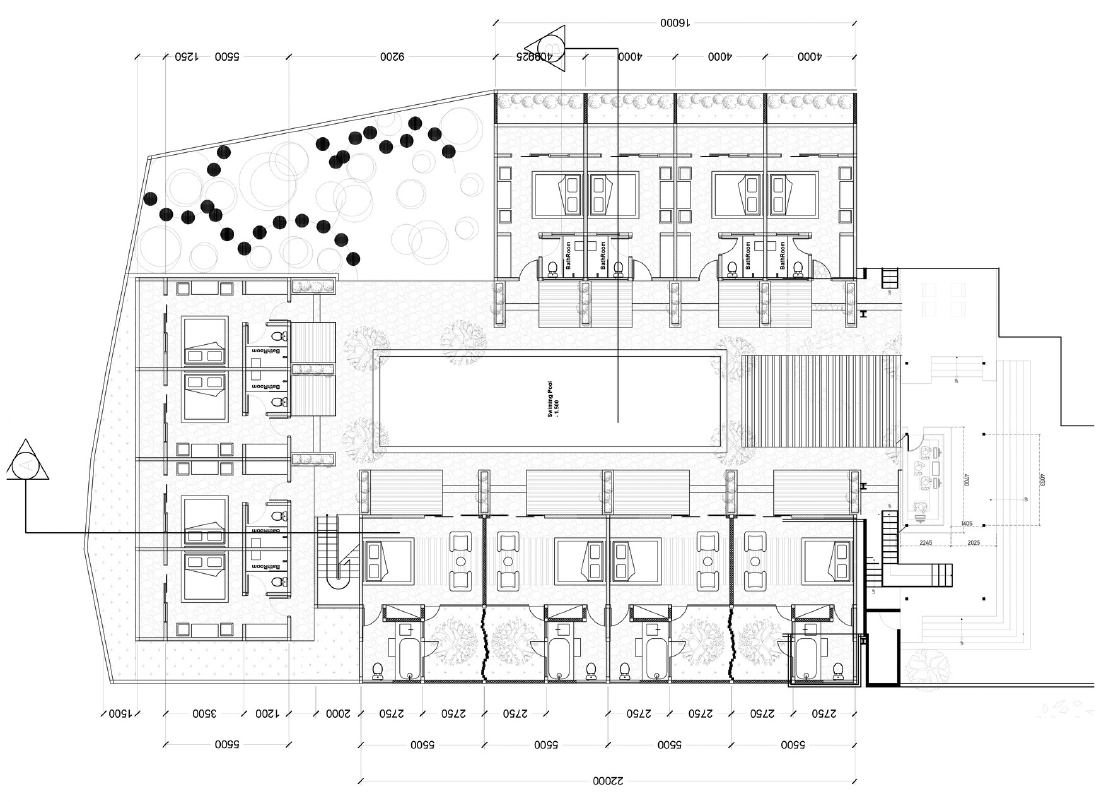
Figure 11. Roam Co-living, Bali, 2015, by Alexis Dornier. Source: Archdaily